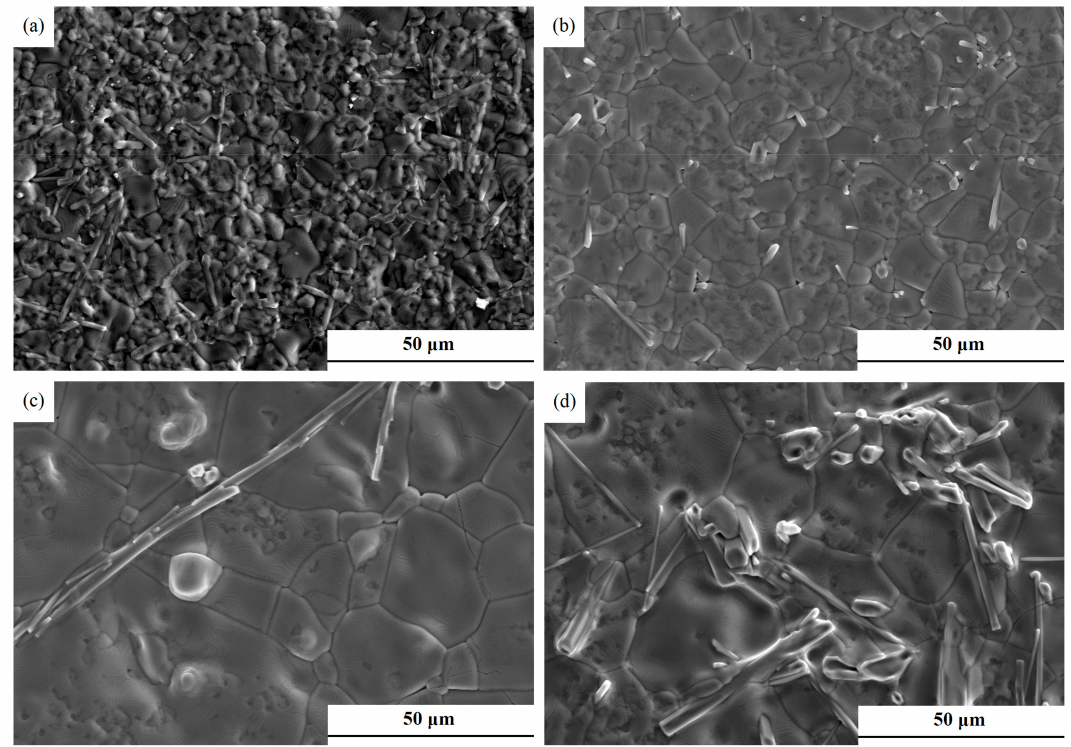
Figure 3. SEM images of 0.65CLT-0.35SMT ceramics sintered at di ff erent temperatures for 60 min: ( a ) 1525 ◦ C; ( b ) 1550 ◦ C; ( c ) 1575 ◦ C; ( d ) 1600 ◦